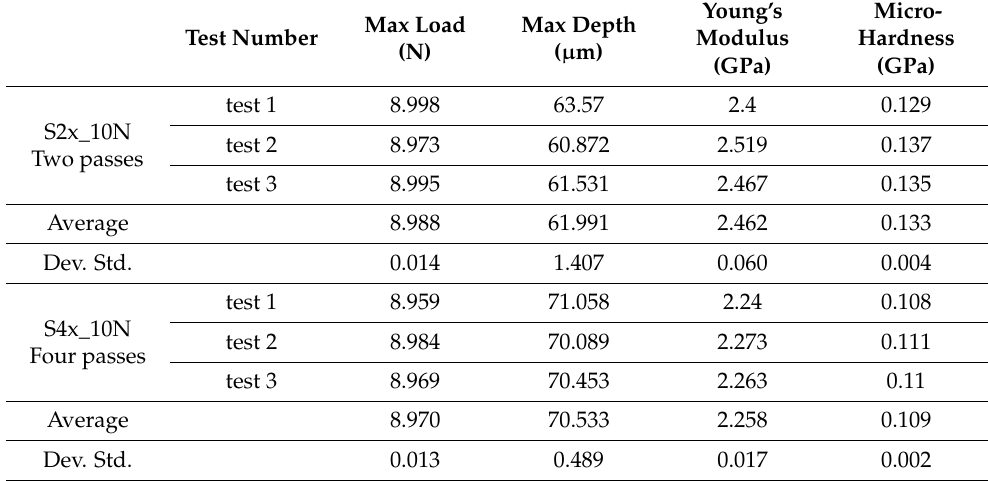
Table 8. Square (S) texture